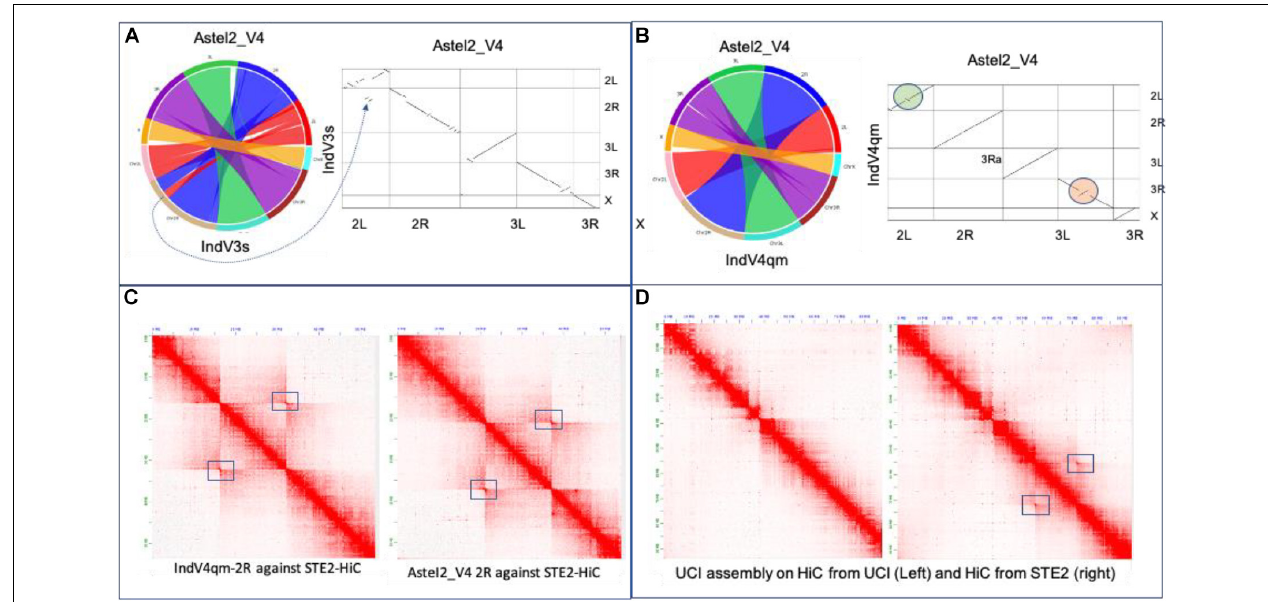
FIGURE 4 | Validation of assemblies. (A) Synteny and dot plot of IndV3s against AsteI2_V4. (B) Synteny and dot plot of IndV4qm against AsteI2_V4 assembly. (C) Contact maps for 2R of IndV4qma (left) and AsteI2_V4 (right) using HiC data from the STE2 strain. (D) Contact maps of chromosome 2 of the UCI assembly against the two HiC datasets for the UCI and STE2 strains.